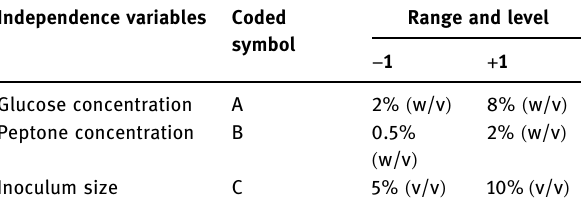
Table 1: Experimental design for BC production Independence variables